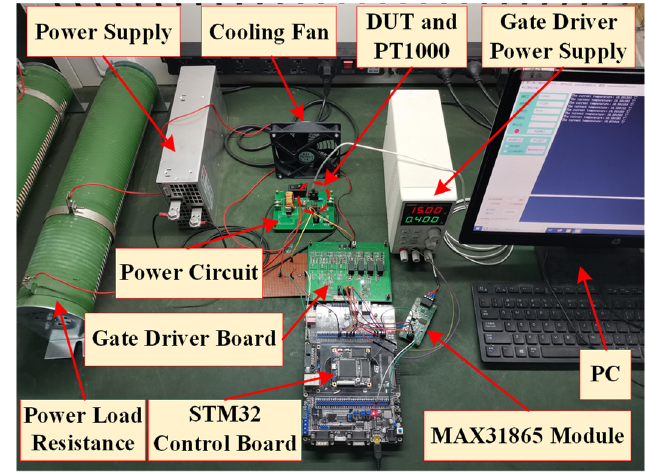
Figure 2. The physical photo of the experimental platform.